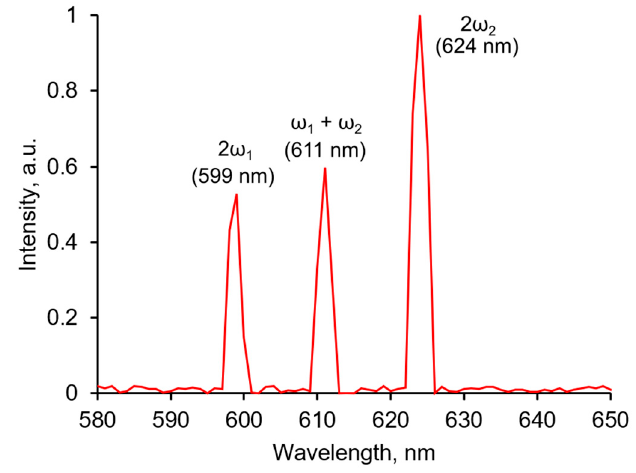
Figure 2. Spectrum of the output SRS radiation converted by a LiIO 3 crystal.